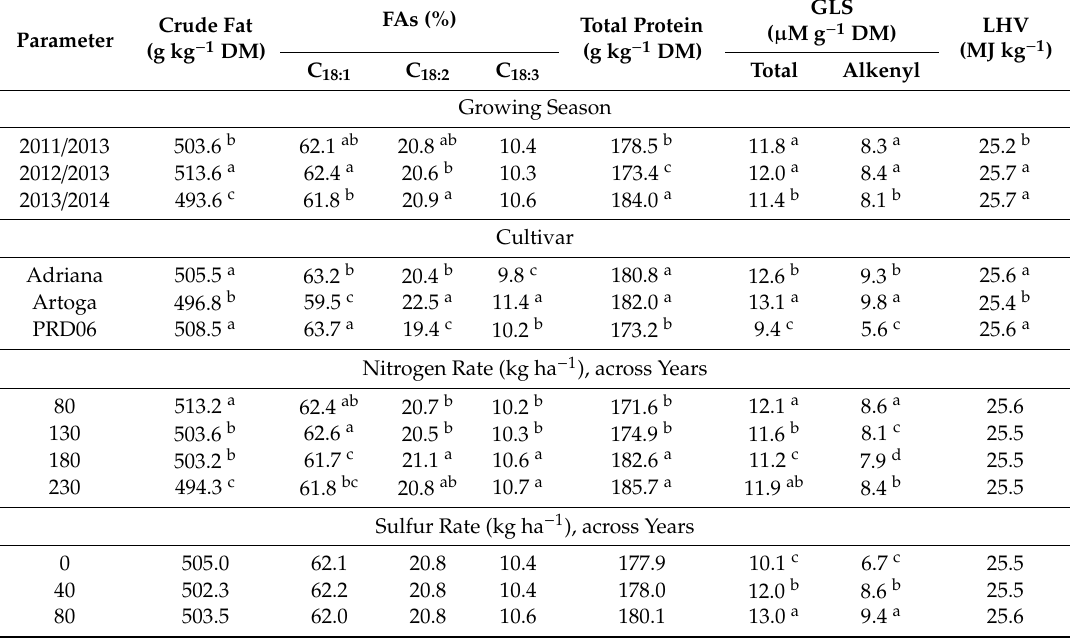
Table 6. Quality of winter oilseed rape